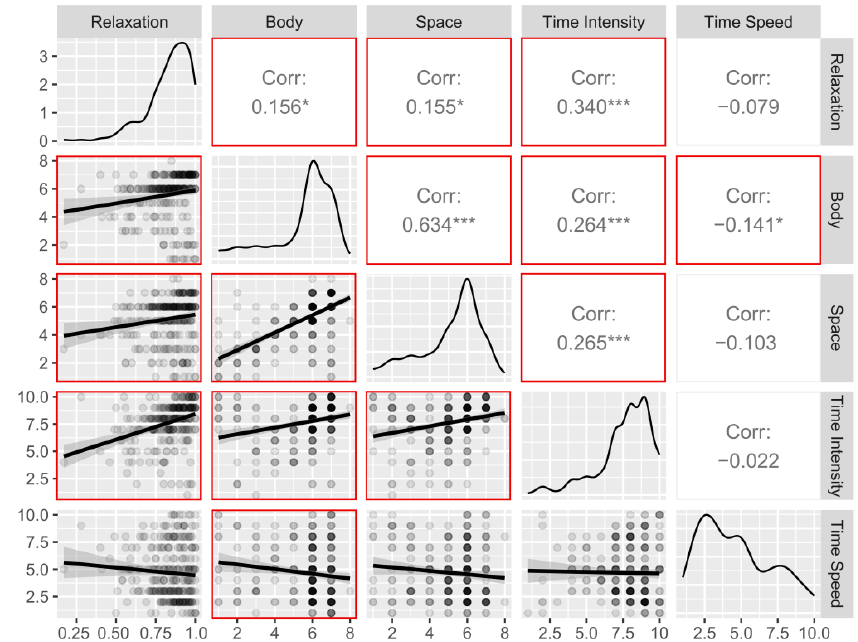
Figure 6. Relationship between pre-training indices: scatterplots, distributions, and Pearson ’ s cor- relations. Significant correlations are framed by the red square. Body = Body Awareness, Space = Space Awareness. *** = p < 0.001, ** = p < 0.01.